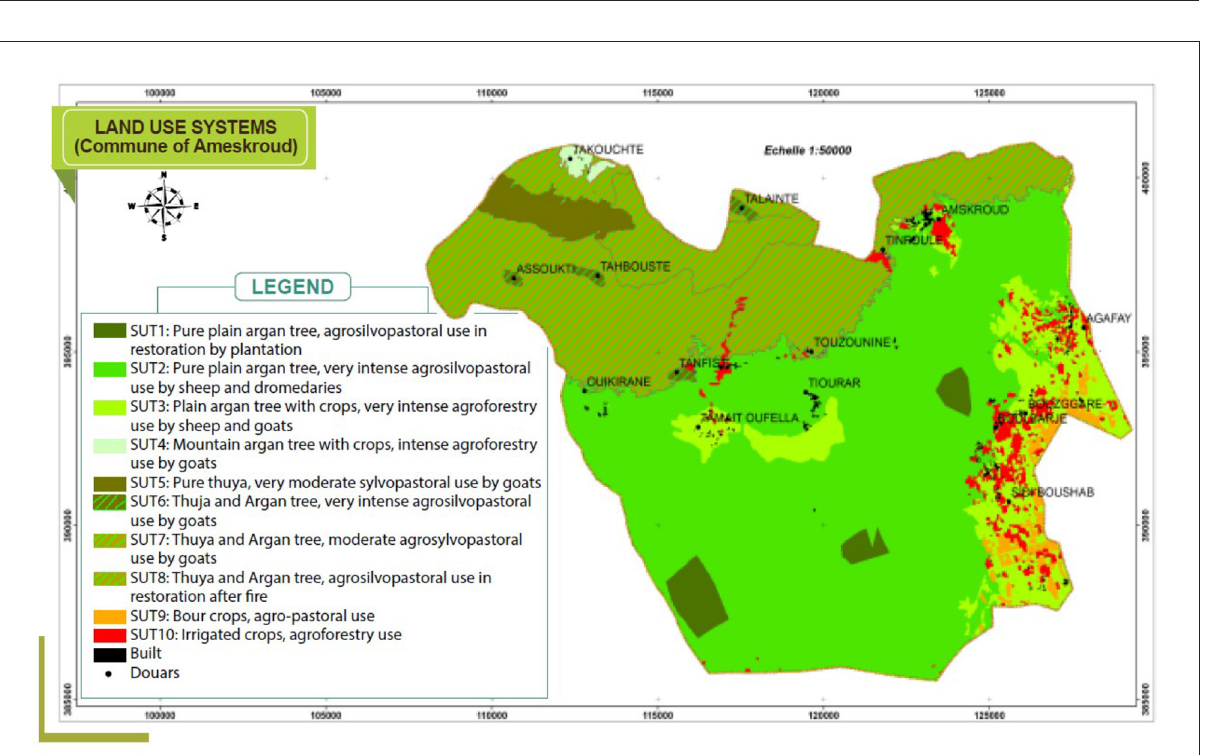
FIGURE11 Land use system map of